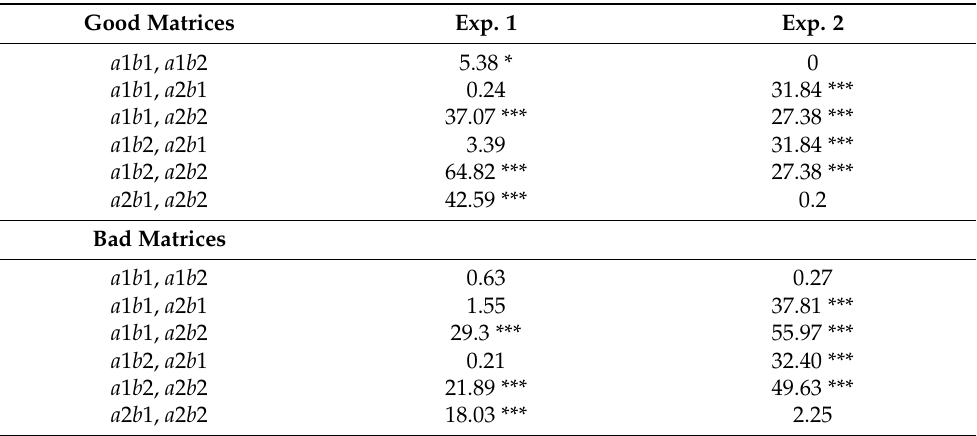
Table 4. Chi square tests for comparisons of rates of checking for all Good and Bad question combinations.